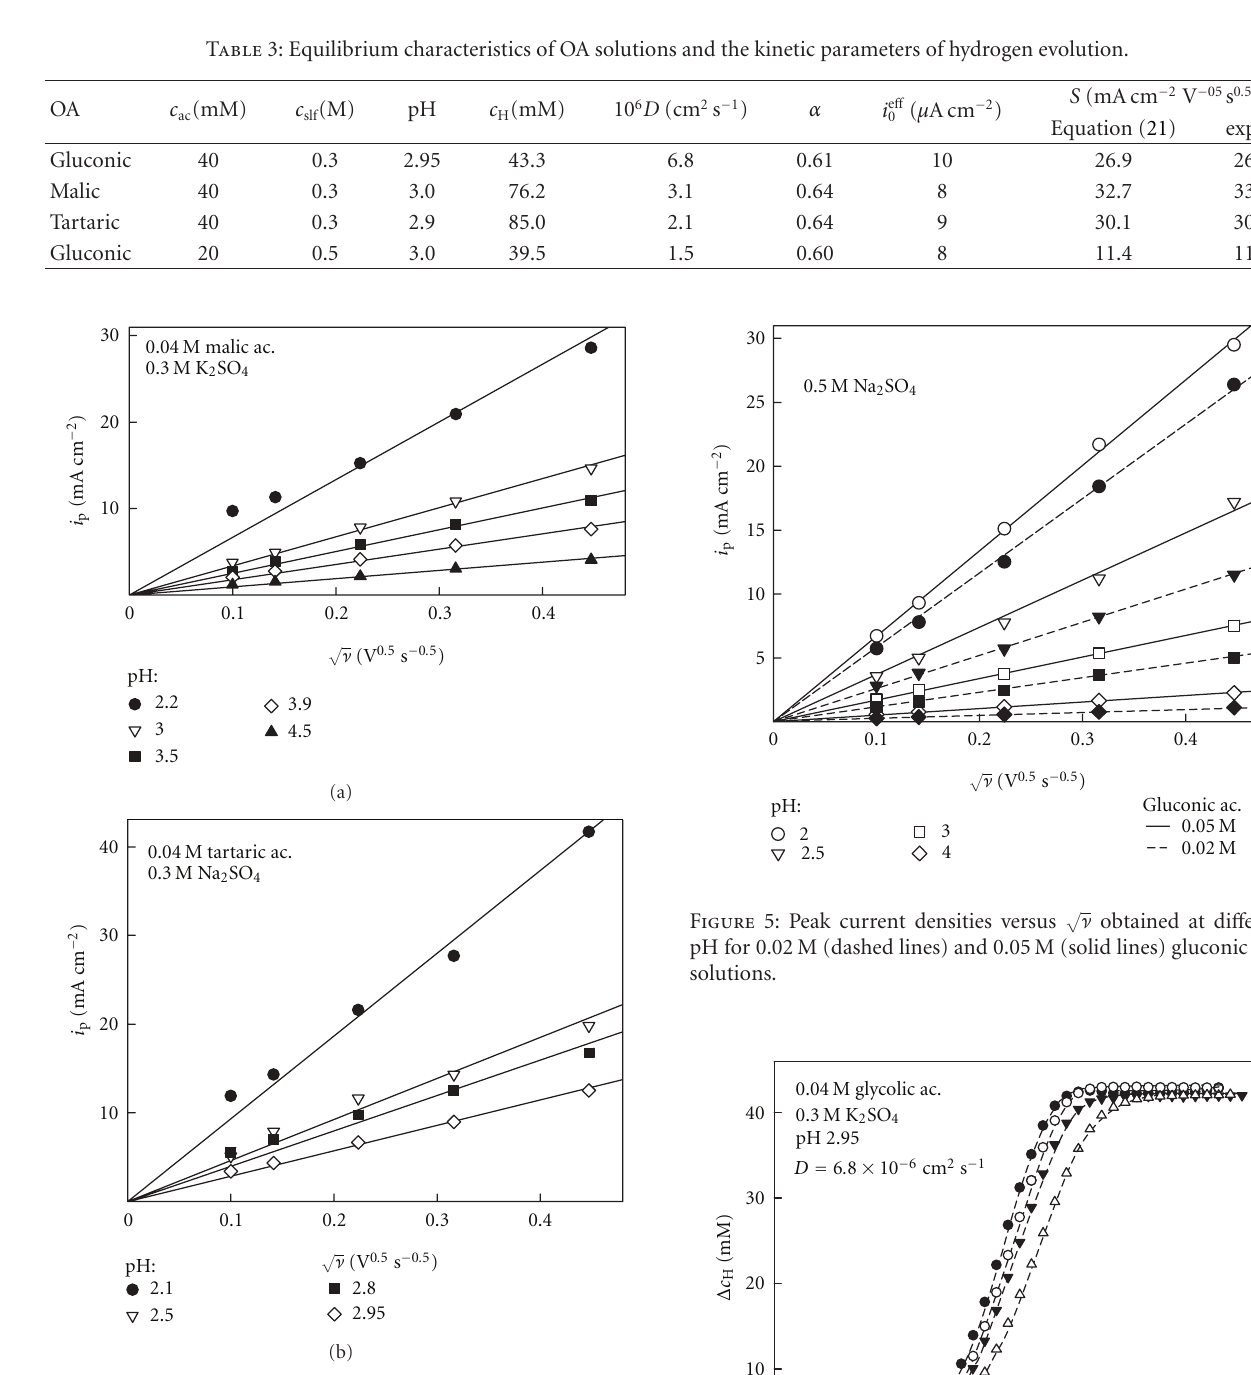
Figure 4: Peak current densities versus for 0.04 M malic and tartaric acid solutions.